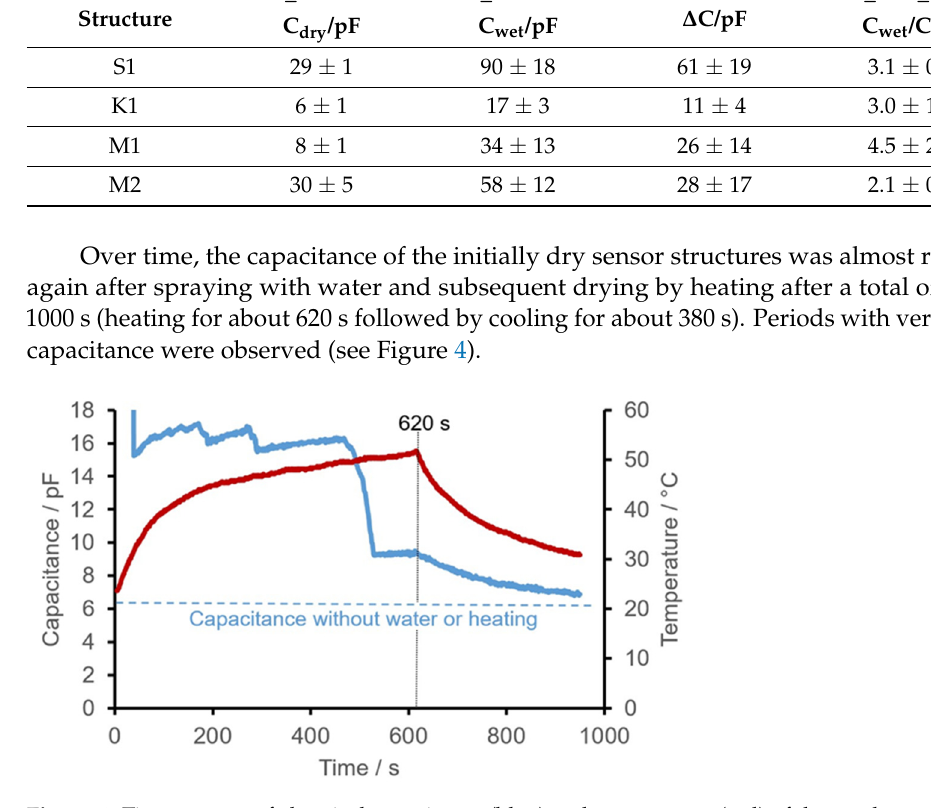
Figure 4. Time courses of electrical capacitance (blue) and temperature (red) of the comb structure K1 after spraying with approximately 1 mL water shown as an example.